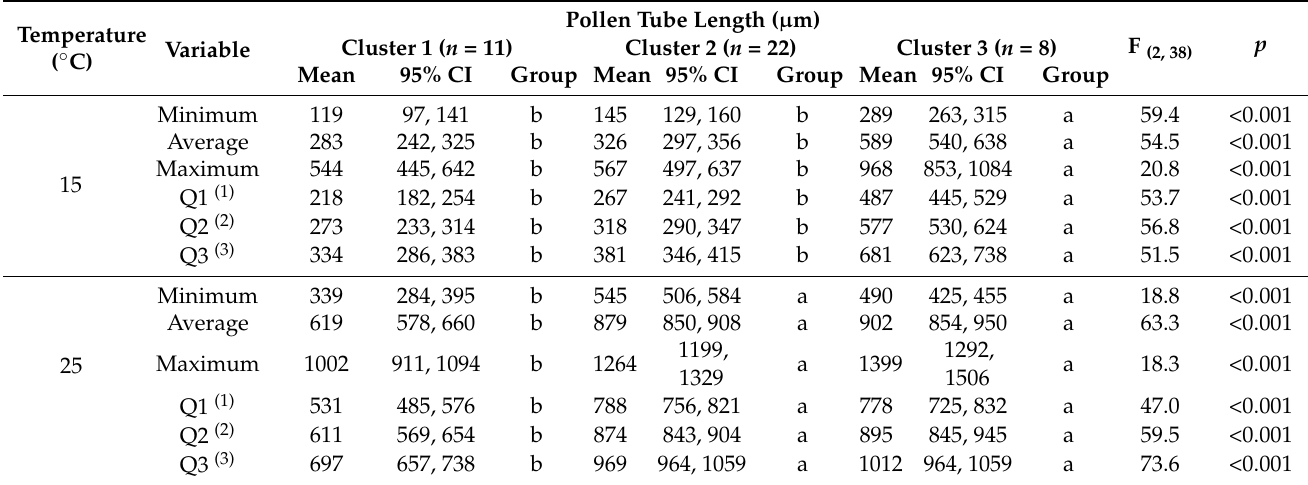
Table 1. Statistical characterization of clusters identified by hierarchical clustering on principal